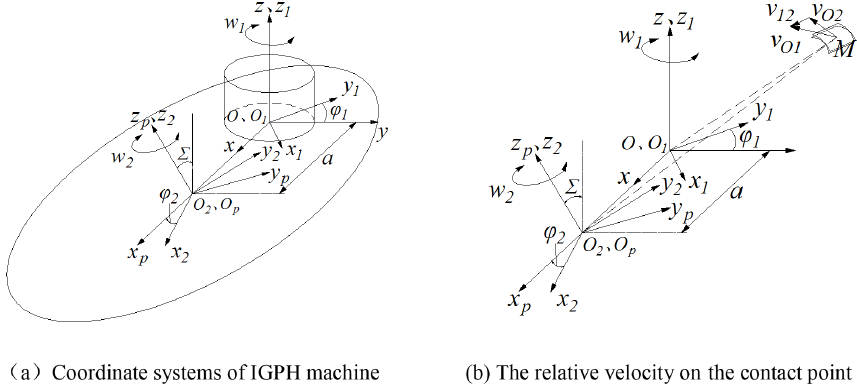
Figure 7. The coordinate systems of the IGPH machine and the relative velocity on the contact point. Table 7. The gear profile error results of IGPH experiments based on the active control method.